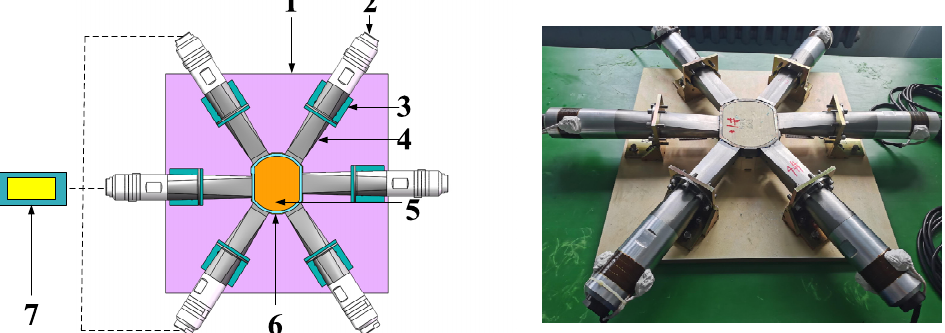
Figure 2. USR system: 1 is Support foundation, 2 is Ultrasonic transducer, 3 is L-shaped fixed plate, 4 is TC4 horn, 5 is Support wood block, 6 is Outer ring component, and 7 is Ultrasonic power.